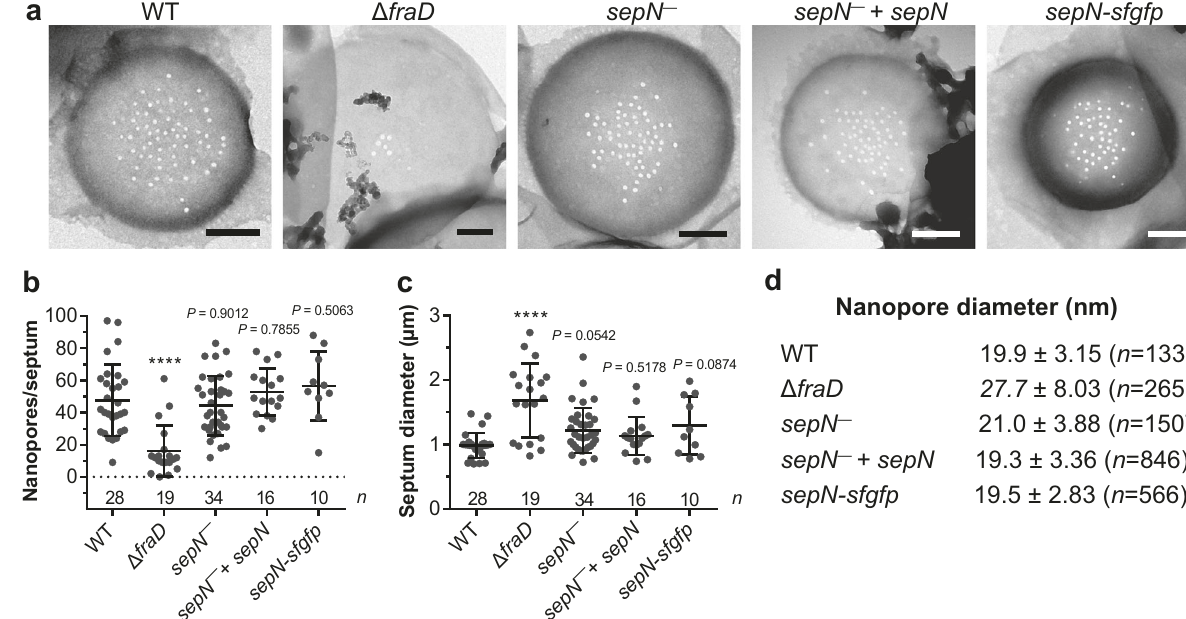
adjustments. **** p ≤ 0.0001. Non-signi fi cant p- values are indicated above. Data were cumulated from four independent experiments representing biological replicates for sepN − , from two independent experiments for WT and Δ fraD